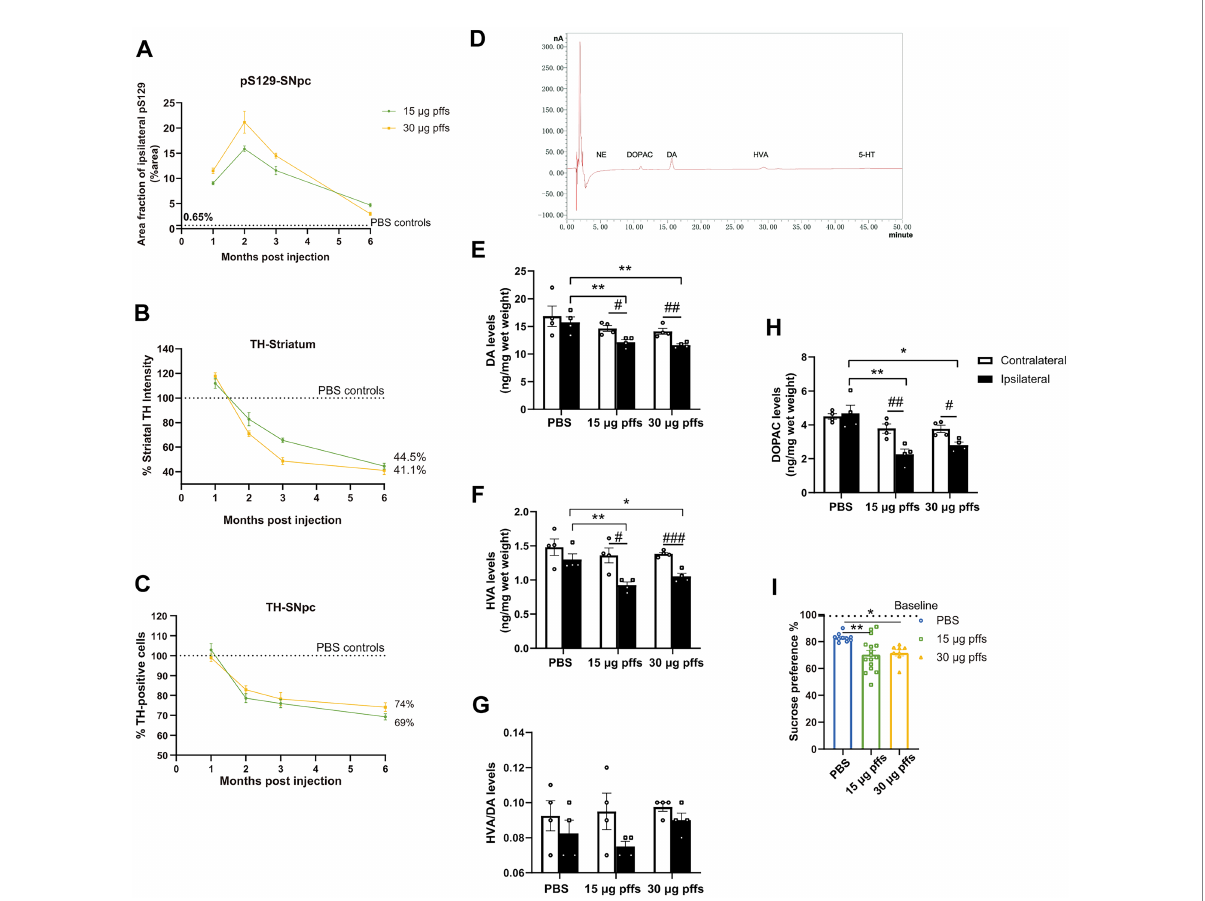
FIGURE 8 Temporal progression and features within the PFFs model. (A) Quantification of the pS129 in the ipsilateral SNpc. (B,C) Fluctuations of TH-positive cells in SNpc and striatum. Data were presented as % of the PBS group. (D) Sample chromatogram of 15 μ g pffs solution. Peaks in order: NE (5 min), DOPAC (11 min), DA (16 min), HVA (30 min), 5-HT (45 min). (E–H) Increased α -Syn pathology lead to a loss of dopamine input to the striatum ( n = 4; * p < 0.05, ** p < 0.01; # p < 0.05, ## p < 0.01, ### p < 0.001). (I) Sucrose preference test performed at 6-months post injection ( n = 8–16; * p < 0.05, ** p < 0.01). All of the data was shown as means ±